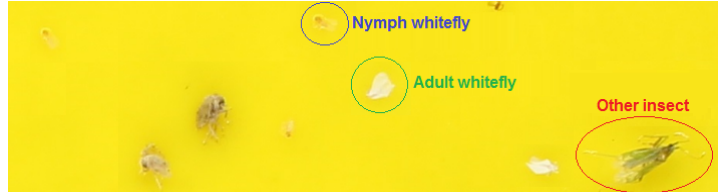
Figure 5. Part of a dataset image with